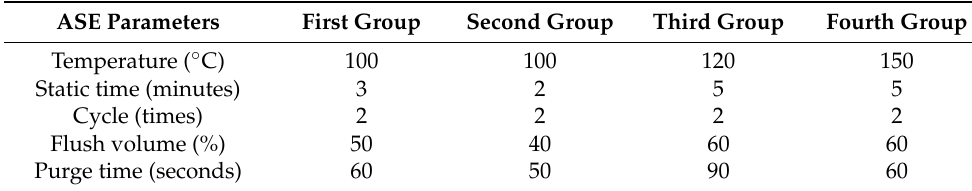
Table 1. Four groups of ASE experimental